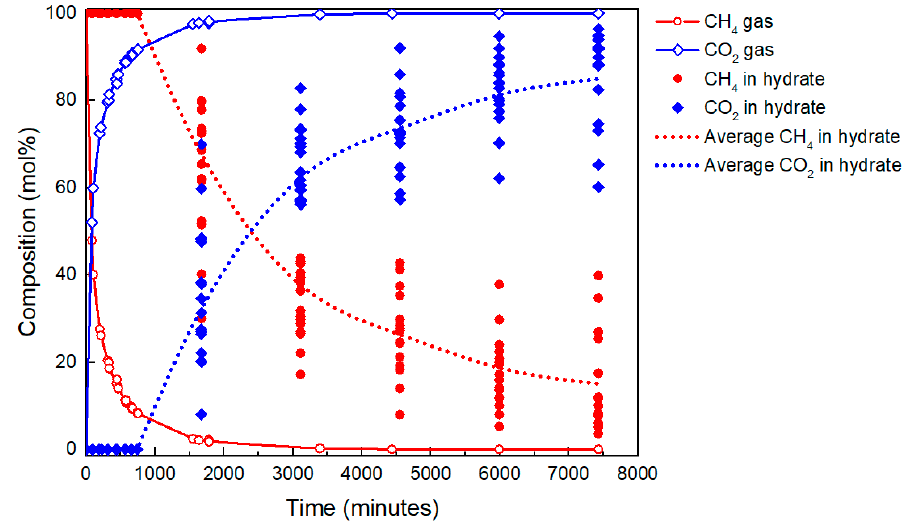
Figure 5. Results of the Raman spectroscopic measurements on the surfaces of 15 selected hydrate crystals, illustrating the exchange process of pure CH 4 hydrates to CO 2 -rich mixed hydrates when exposed to CO 2 gas. The dashed lines show the average molar composition changes in CH 4 (red) and CO 2 (blue) in the hydrate phase fitted by smooth curves. The standard deviation of the average molar composition ranged from 0.6 mol% to 5.3 mol% according to the data from three repeated experiments.